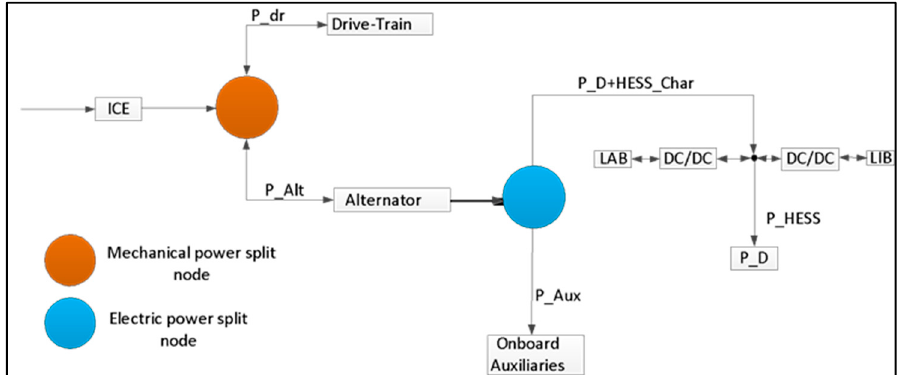
Figure 1. Electric power flow system with HESS in Transport vehicle.